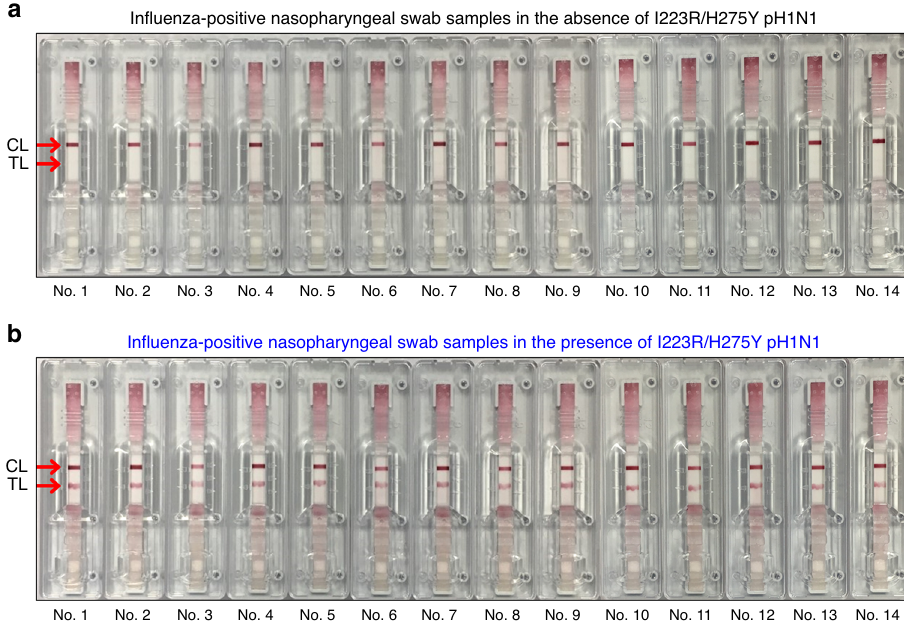
Fig. 8 LFA of I223R/H275Y pH1N1 in human nasal fl uid samples using A4. Optical images of A4-based lateral fl ow systems after detection of in fl uenza- positive nasopharyngeal swab samples a in the absence or b presence of I223R/H275Y pH1N1 (10 3 PFU).